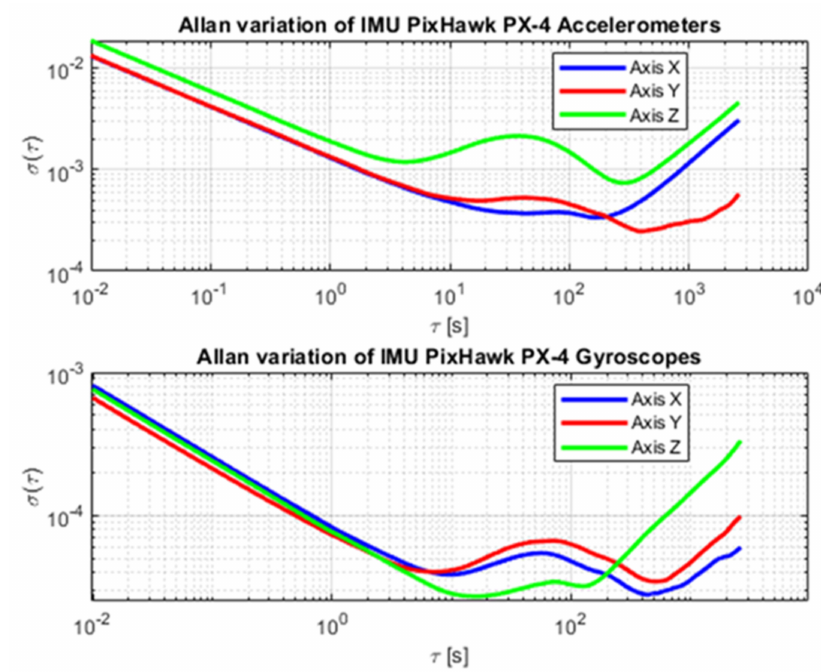
Figure 13. Graphs of Allan variation of IMH PixHawk PX-4